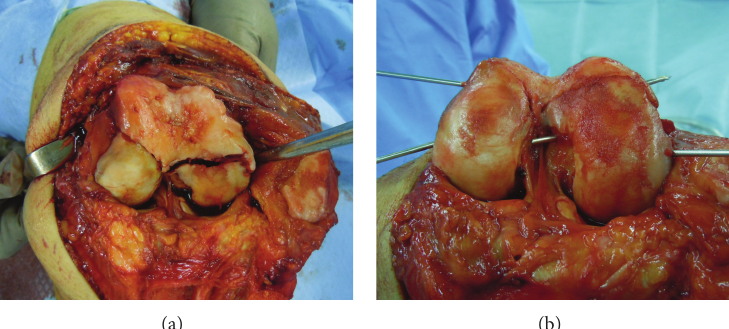
Figure 3: Intraoperative photographs illustrating the exposure of the bicondylar Hoffa fracture through a lateral parapatellar arthrotomy (a) and provision reduction with Kirschner wires (b).